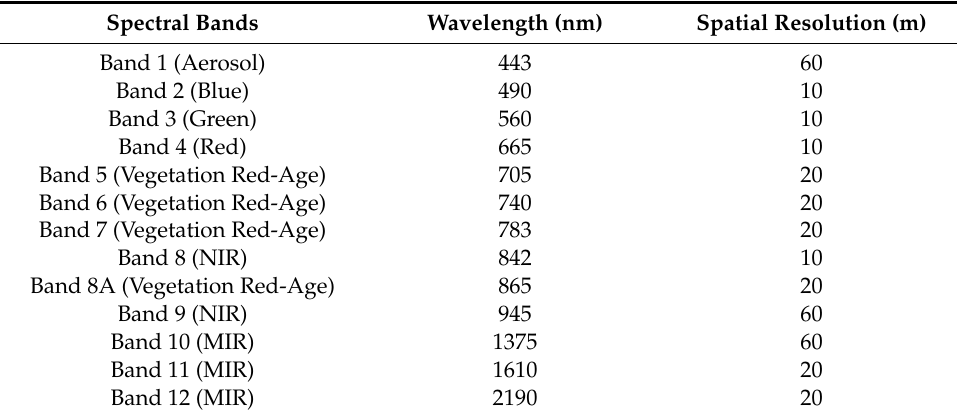
Table 2. Sentinel-2 (S-2) spectral band